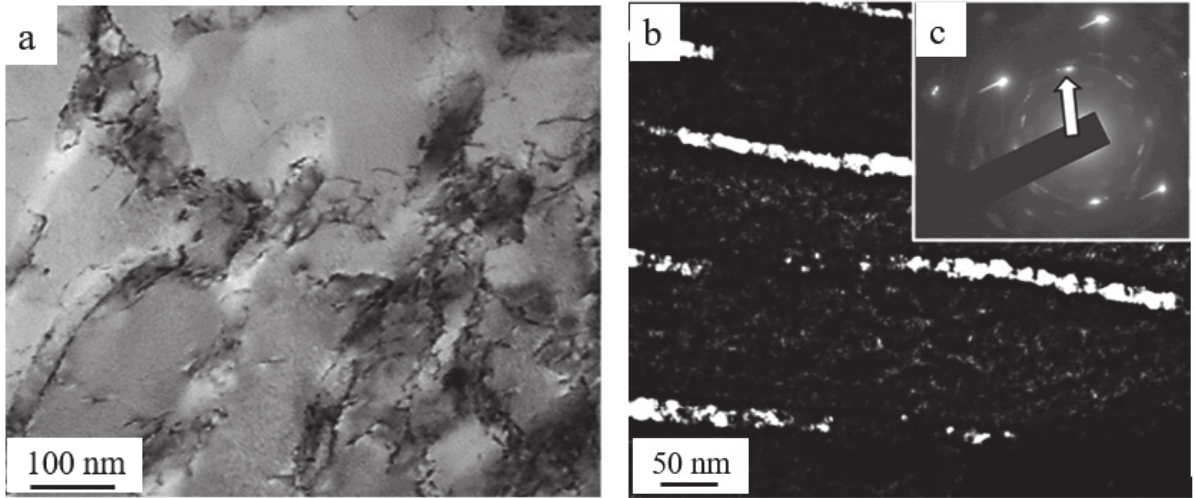
Figure 4. A TEM image of the steel deformed structure ( ε = 50%); ( a )—bright field; ( b )—dark field obtained in the reflection [ 012 ] Fe 3 C+ [ 110 ] α -Fe; c —microelectron diffraction pattern. On ( c ) arrows indicate the reflection of a dark field formation.